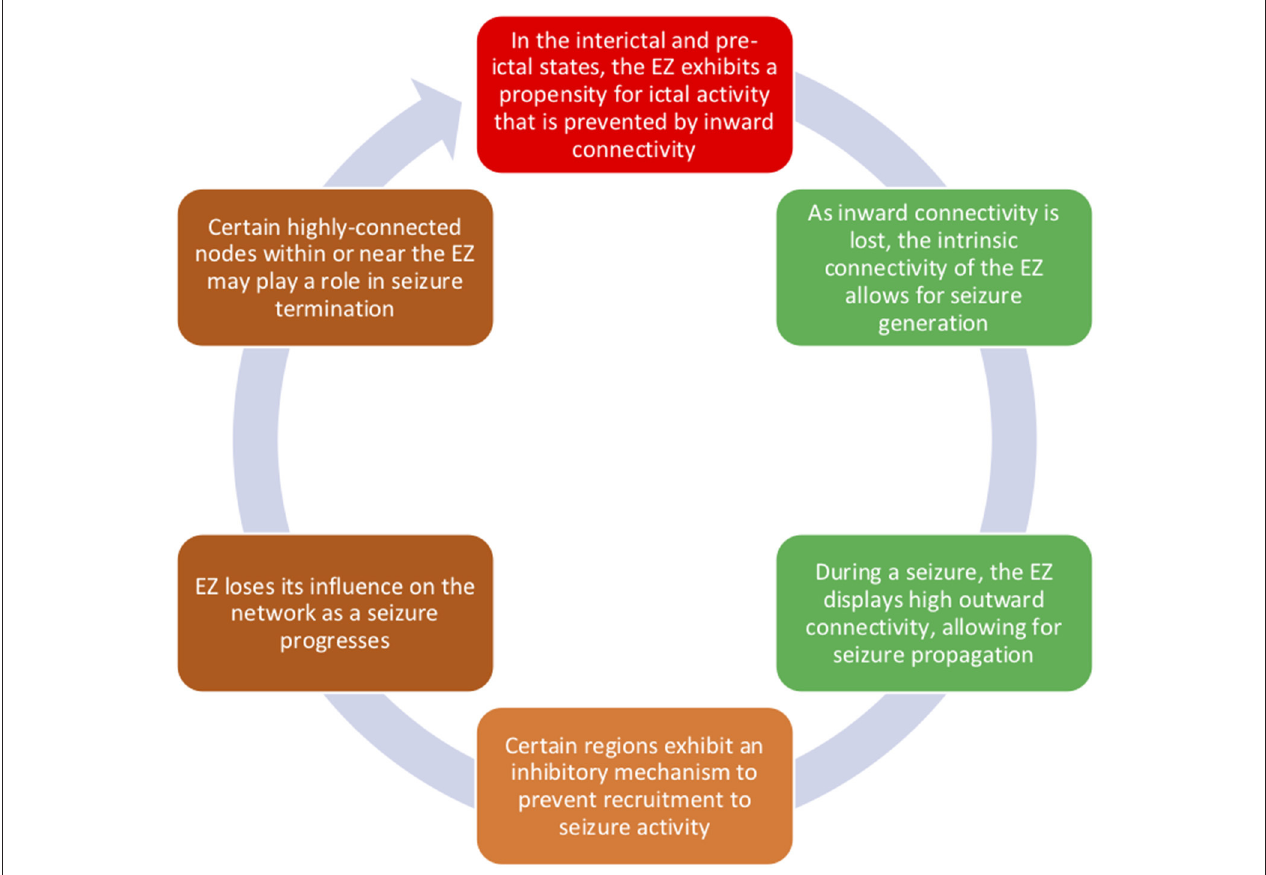
FIGURE 1 | Connectivity of the epileptogenic zone changes between interictal, pre-ictal, and ictal time periods. During interictal periods, the EZ displays both high outward connectivity, which is likely related to the EZ’s seizure-generating activity, and inward connectivity, which is possibly preventing a seizure from starting. During seizure onset, we propose that such inward control is lost and that the internal connectivity of the EZ allows for seizure generation. Epileptogenic influence spreads from the EZ via its high connectivity to propagation zones. However, the EZ becomes less influential in the network over time, and regions in or near the EZ may be involved in seizure